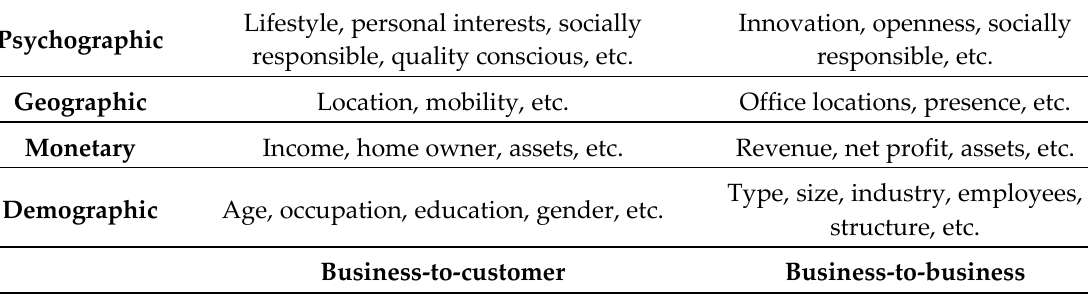
Figure 3. Customer groups’ segmentation overview.